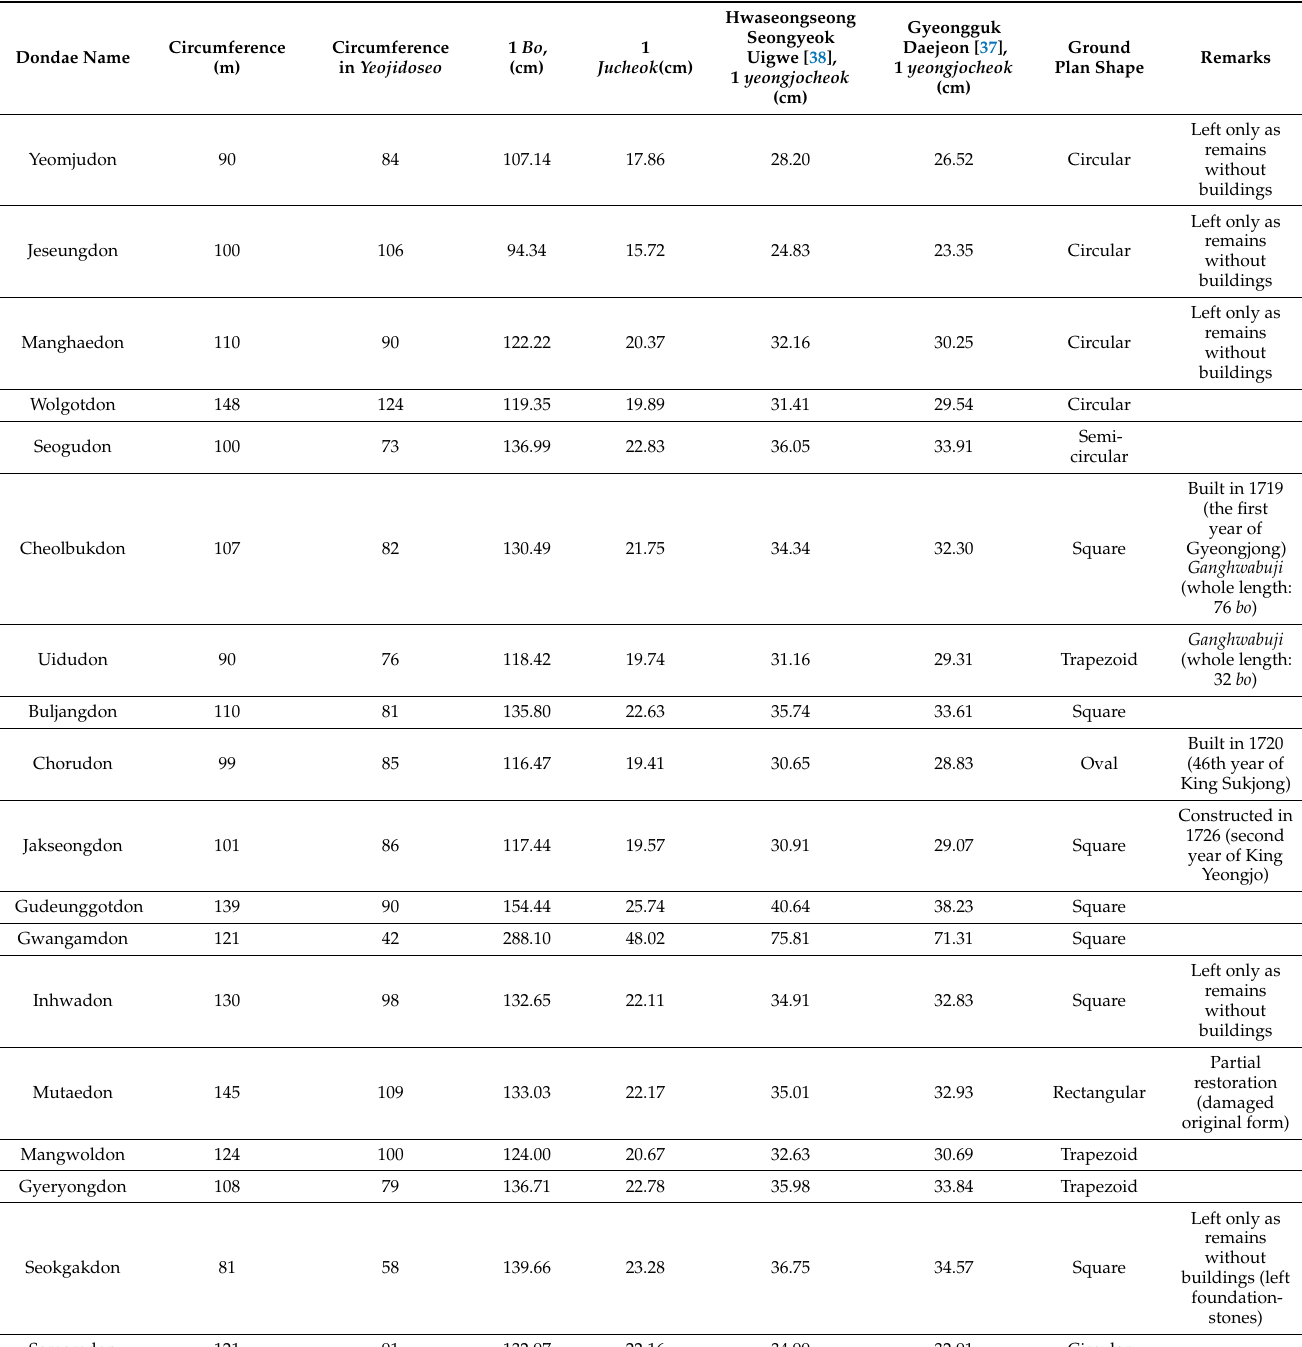
(Table 2). The Yeojidoseo is a reliable documentary source that mentions the perimeter of Dondae forts recorded in bo measurement units. The measured value using the modern metric system was divided by the circumference of the bo unit to obtain the value of one bo and converted to the yeongjocheok unit in the early and late Joseon Dynasties. To understand the operation of vernacular construction methods to maintain the regular scale employing the regular size of materials to build the forts, this study noted that these forts applied early yeongjocheok systems by comparing the cheok -unit measures. Table 2. Use of yeongjocheok (construction measurement unit) system for sustainable construction managements in Ganghwa Dondae